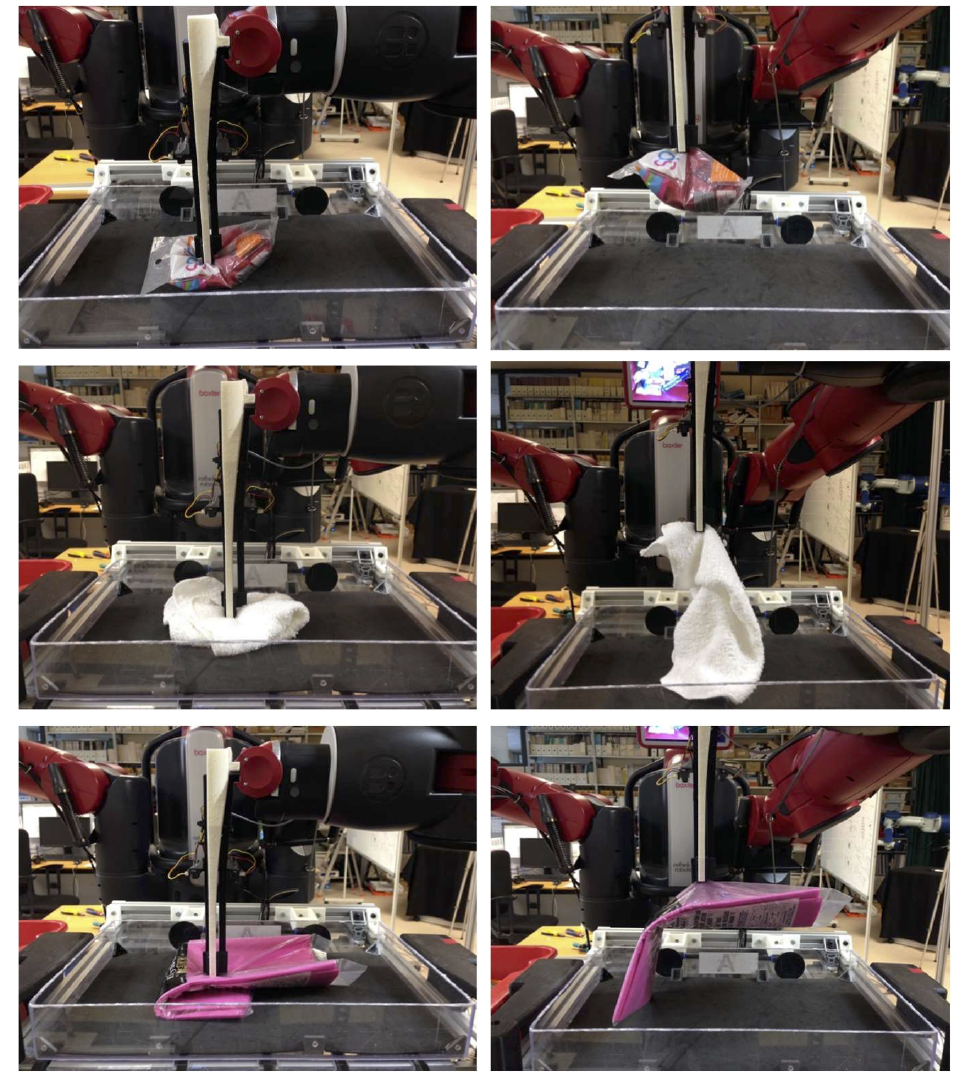
Figure 17. CNA with Pincher; successful grasp of balloons, face cloth and table cloth.